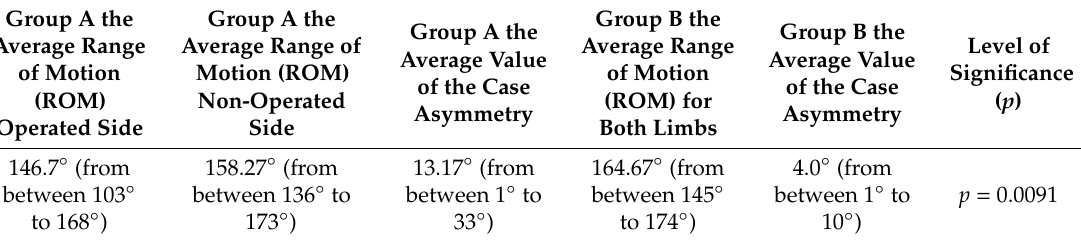
Table 4. Latissimus dorsi flexibility